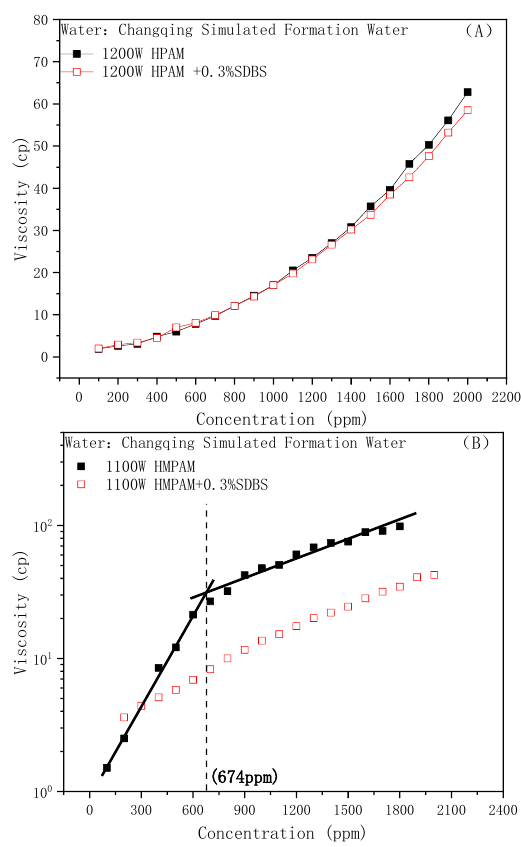
Figure 3. Effect of SDBS on the polymer viscosity: ( A ) HPAM, ( B )